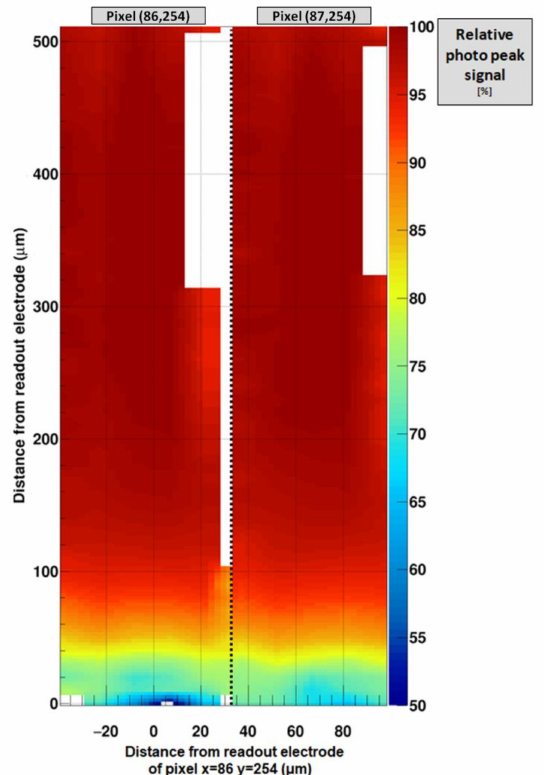
Figure 14. Relative signal of the photo peak for the two pixels under investigation: x = 0 indicates the center of pixel (86, 254), x = 75 indicates the center of pixel (87, 254), the black dashed line indicates the pixel boundary. The reduction of the induced signal due to the missing hole contribution, when the photons are absorbed close to the readout electrode, is clearly visible. For the white areas, no photo peak could be estimated reliably due to too much charge sharing. It is unclear whether the unsymmetrical behavior at the pixel boundary is due to a non-optimal alignment of the scan axis or due to variations of the effective pixel size in GaAs:Cr sensors (see following